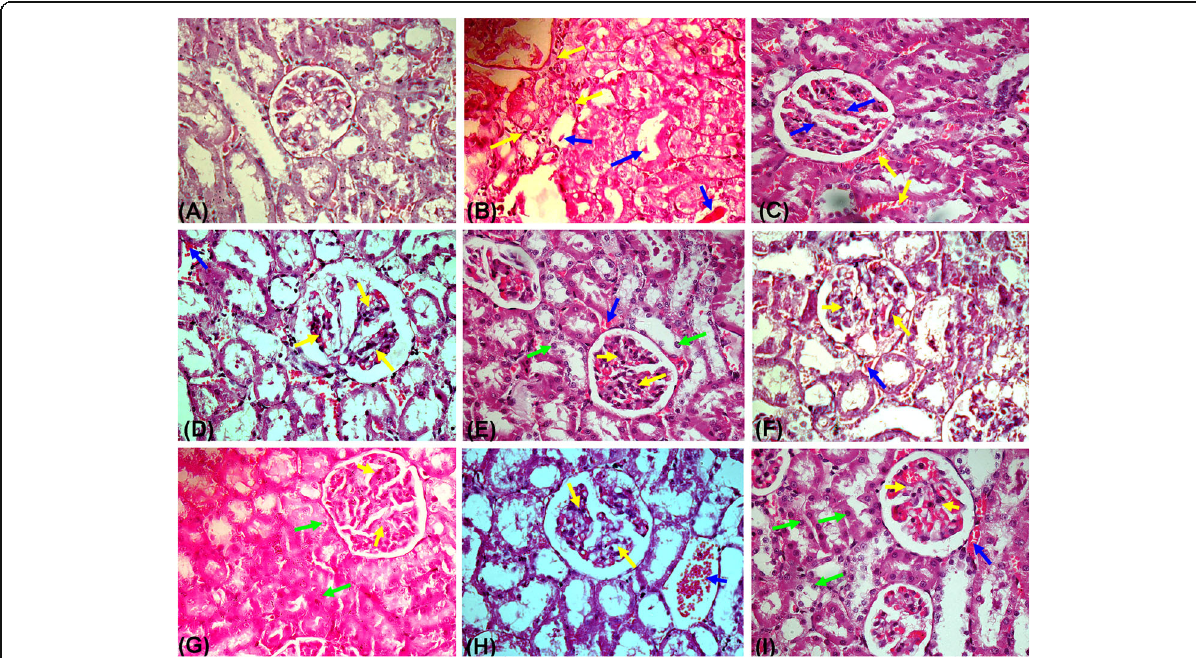
Fig. 3 Photomicrograph of control and treated rats kidney (A-I) a Control rats showing renal tubules and glomeruli are normal, b Gentamicin sulphate induced rat kidney showing severe intertubular hemorrhage (yellow arrows), degeneration, desquamation and necrosis in tubules (blue arrows), c Cystone exposed rats showing mild tubular epithelial changes; hyaline casts in tubules (blue arrows), low intertubular hemorrhage (yellow arrows), d E. pyriformis fruit juice (100mg/kg BW) showing intertubular hemorrhage (yellow arrows), mild tubular epithelial changes; hyaline casts in tubules (blue arrow), e E. pyriformis fruit juice (400mg/kg BW) showing low intertubular hemorrhage (yellow arrows), intact nucleus (green arrows), reduced hyaline casts in tubuler lumen (blue arrow), f M. nagi fruit juice (100mg/kg BW) showing intertubular hemorrhage (yellow arrows), mild tubular epithelial changes; hyaline casts in tubules (blue arrow), g M. nagi fruit juice (400mg/kg BW) showing low intertubular hemorrhage (yellow arrows), intact nucleus (green arrows), h M. esculenta fruit juice (100mg/kg BW) showing intertubular hemorrhage (yellow arrows), mild tubular epithelial changes; hyaline casts in tubules (blue arrow), i M. esculenta fruit juice (400mg/kg BW) showing low intertubular hemorrhage (yellow arrows), intact nucleus (green arrows), reduced hyaline casts in tubuler lumen (blue arrow)